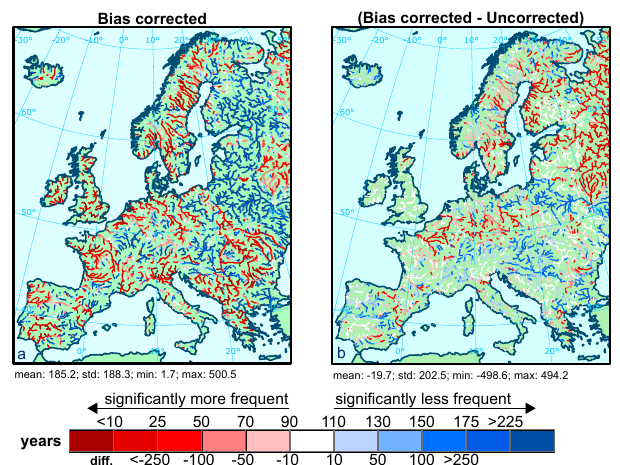
Fig. 13. (a) Recurrence interval of a 100-yr event observed in the control period (1961–1990) for the long-term future (2070–2099), and (b) difference (yr) for the recurrence interval of a 100-yr event between hydrological simulations driven by bias corrected and un- corrected climate